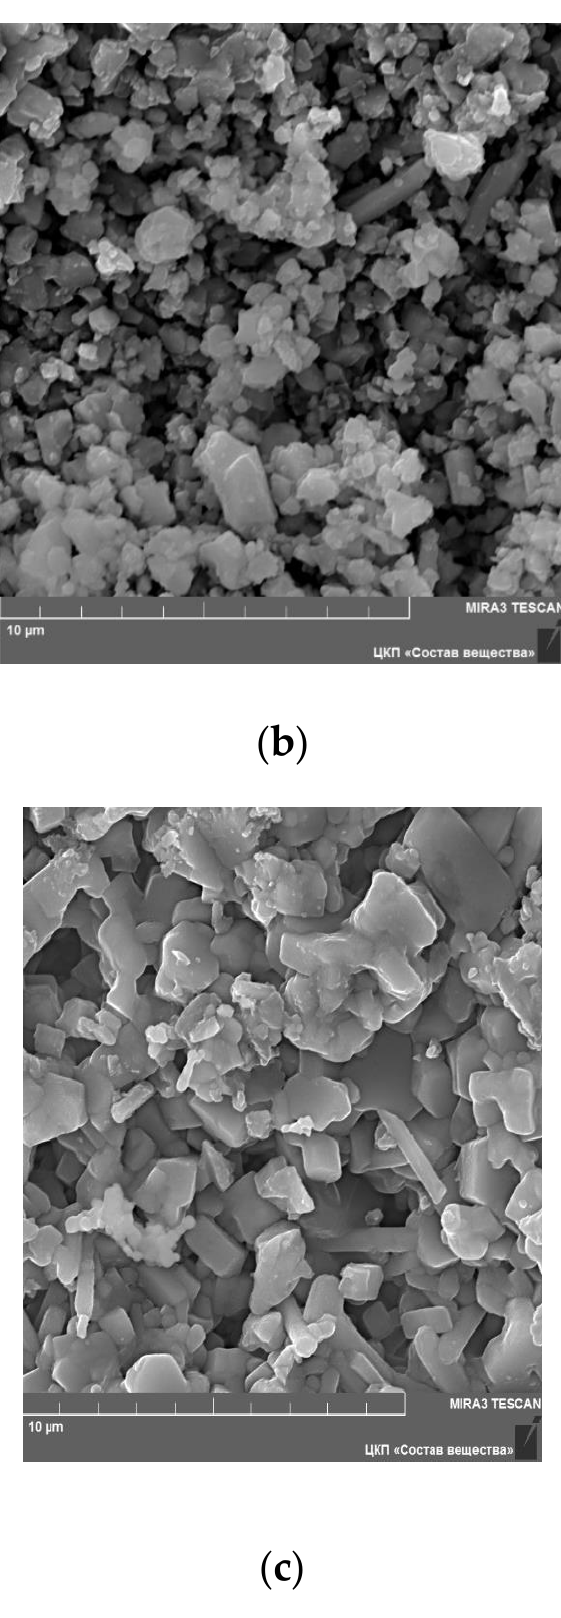
Figure 5. SEM images for the surface of Li 6 Zr 2 O 7 (sintered at 950 °C) ( a ), Li 5.8 Zr 1.8 Ta 0.2 O 7 ( b ), and Li 5.8 Zr 1.8 Nb 0.2 O 7 sample ( c